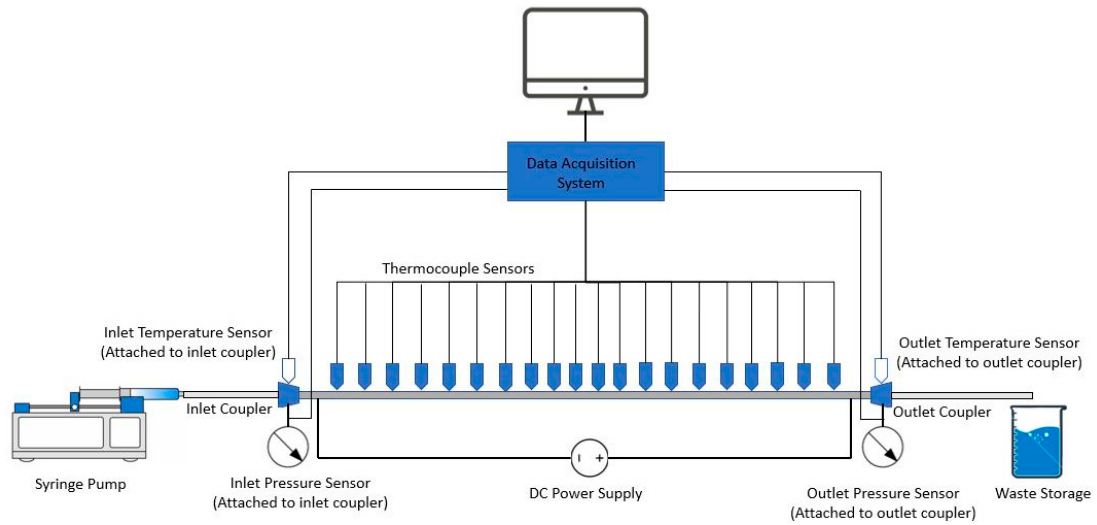
Figure 10. Experimental setup diagram.